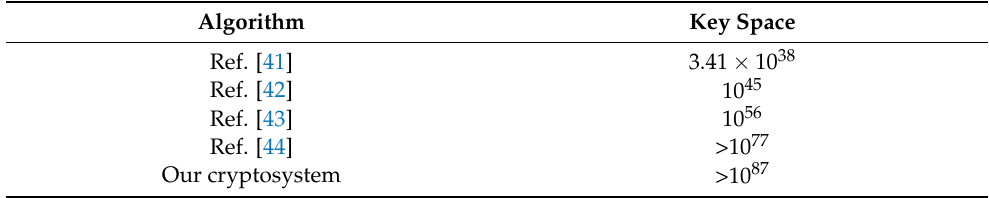
Table 1. Comparison of key space among several algorithms.